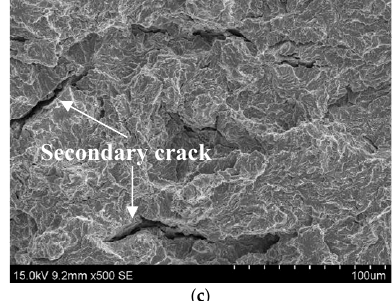
Figure 5. Typical SEM observations of real SSC fracture surface in DCB sample tempered at ( a ) 650; ( b ) 700; and ( c ) 720 °C, with the corrosion film removed.